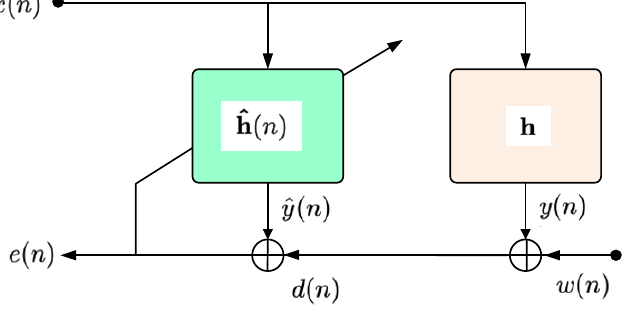
Figure 17. The system model.